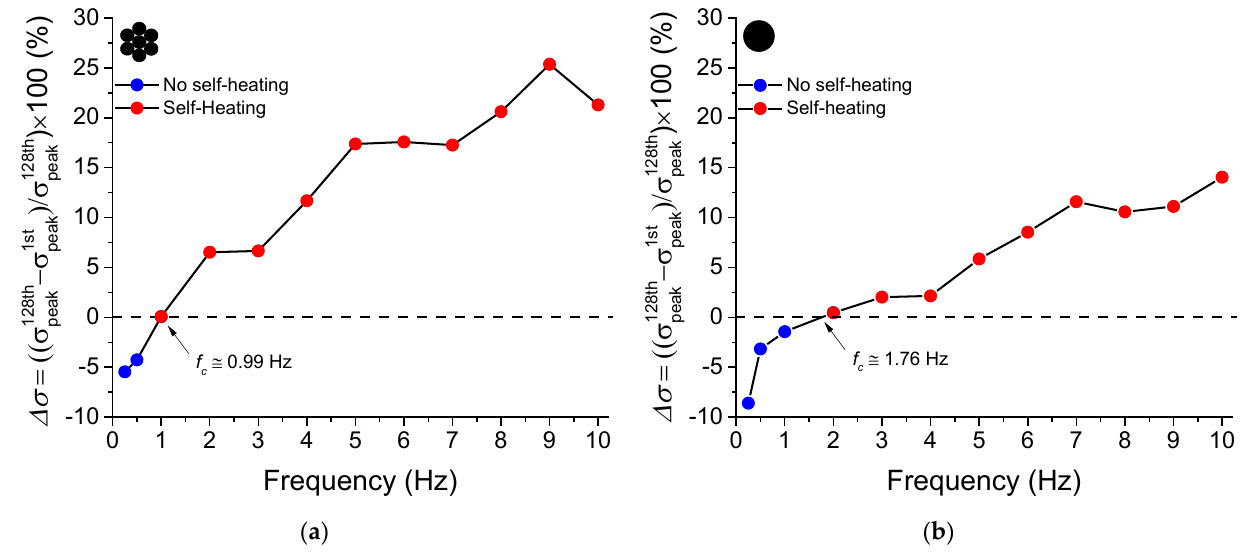
Figure 8. Critical frequency of self-heating. ( a ) SMA NiTi micro cable. ( b ) Reference element. For the micro cable (Figure 8a), the Δ σ value is negative, i.e., the peak stress for the 128th cycle is lower than the peak stress for the 1st cycle, at the frequencies of 0.25 Hz and 0.5 Hz. From 1 Hz, Δ σ is positive and increases almost linearly with the loading frequency up to 9 Hz, when the stress increases approximately 25.5%.